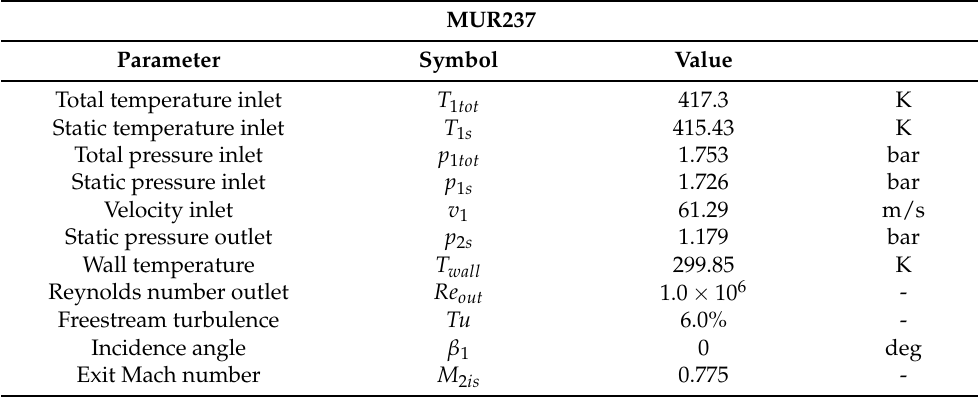
Table 1. Flow parameters and boundary conditions for the numerical investigation.